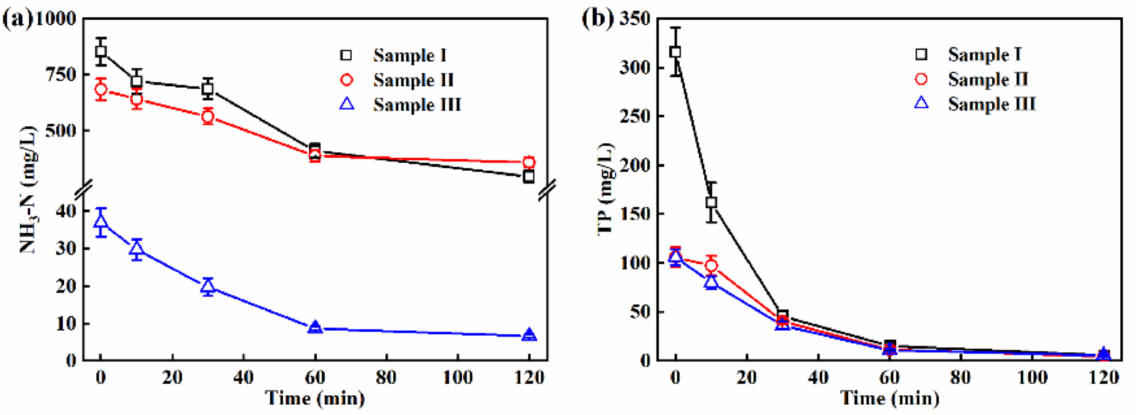
Figure 5. Changes in ( a ) NH 3 -N and ( b ) TP of wastewater in EO treatment at 50 mA/cm 2 current